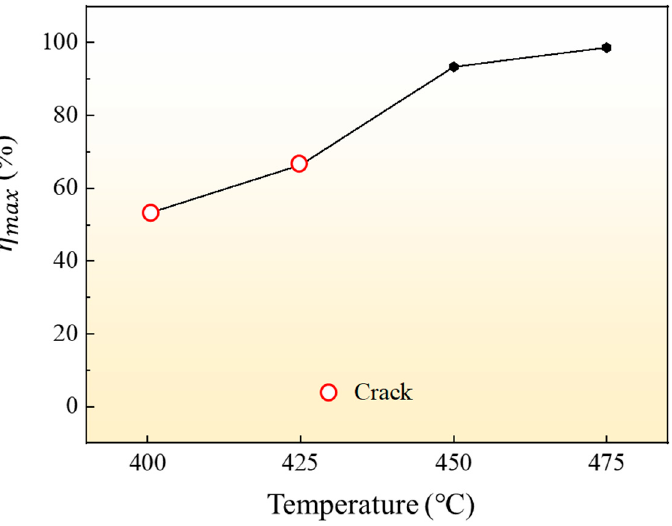
Figure 11. Influence of different temperatures on 𝜂 (cid:3040)(cid:3028)(cid:3051)(cid:4593) at forming pressure 2.5 MPa.